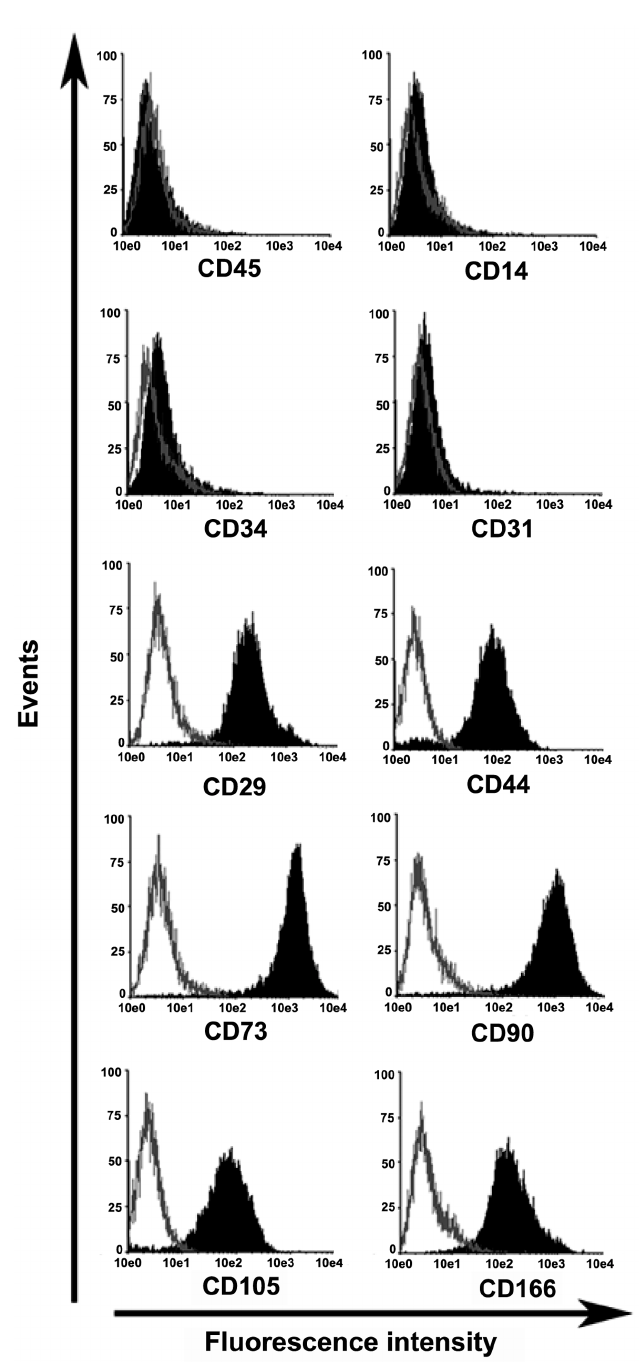
Figure 1. Characterization of umbilical cord Wharton’s jelly (WJ)-derived mesenchymal stem cells (uMSCs). The cells were cultured as described in Section 2.3. As shown in the figure, flow cytometric experiments demonstrated that the WJ-derived cells expressed a panel of markers typical for MSCs, but not for hematopoietic or endothelial lineages. The results are shown for cells obtained from six umbilical cords, and the shape and position of the overall profiles shown here were consistent with those of the individual profiles for cells obtained from passages 5–8.